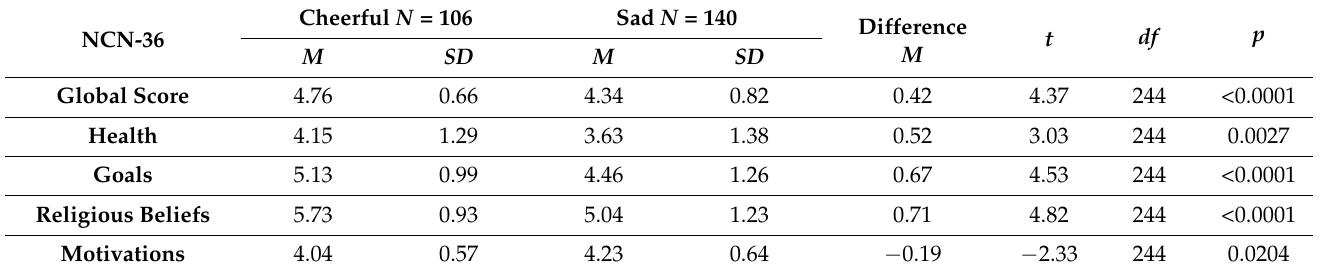
Table 1. Hope of people in the terminal phase of cancer due to mood in the study group N =